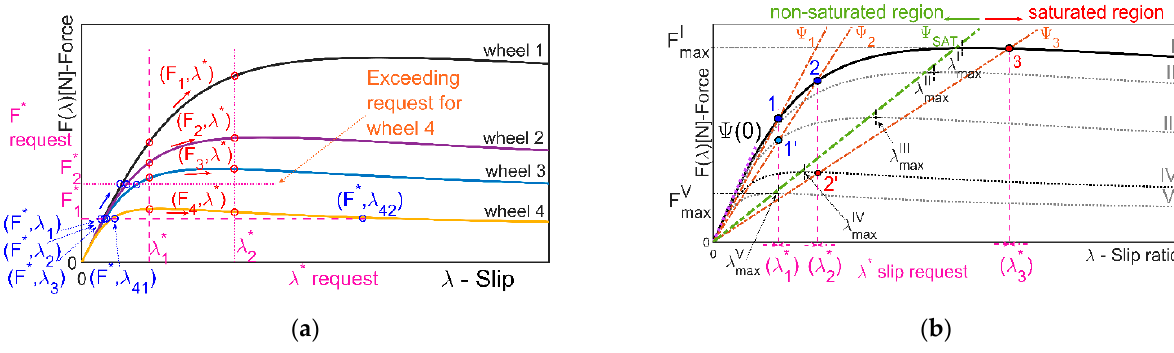
Figure 3. Wheel Speed/Slip control: ( a ) torque (TV) vs. slip control (SV); ( b ) Force-Slip 𝐹(𝜆) − 𝜆 operating point (SV case).